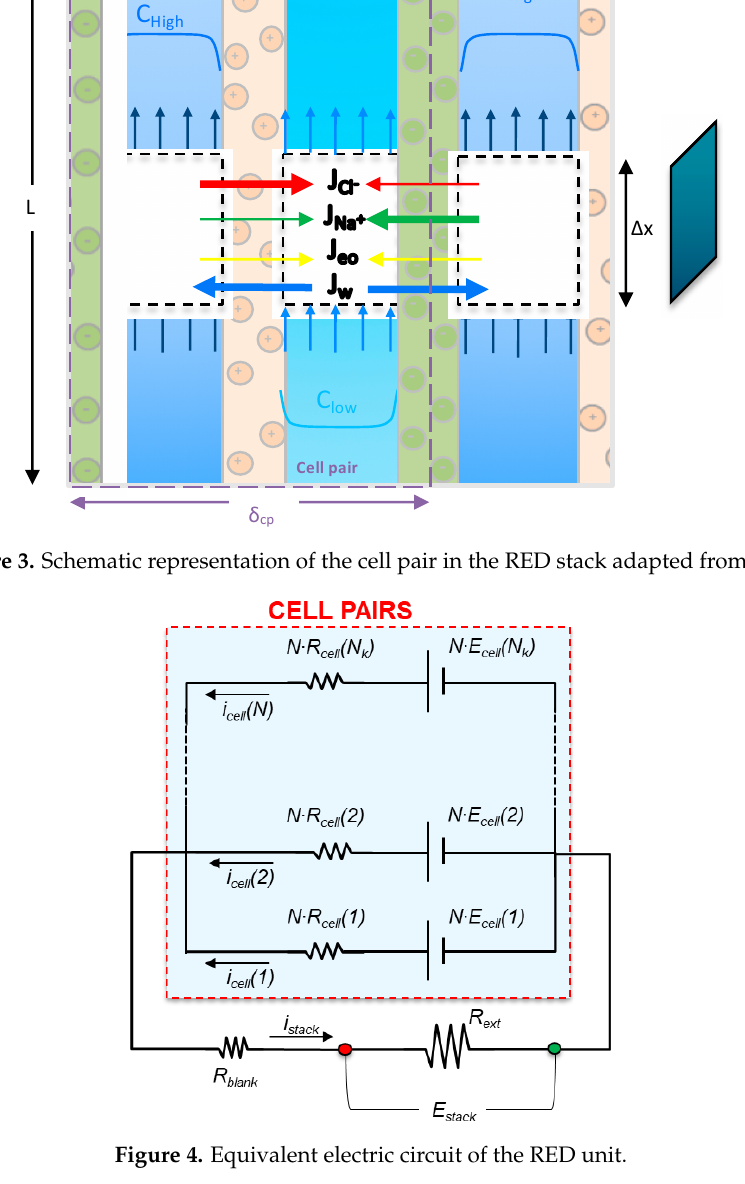
Figure 3 . Schematic representation of the cell pair in the RED stack adapted from [45].